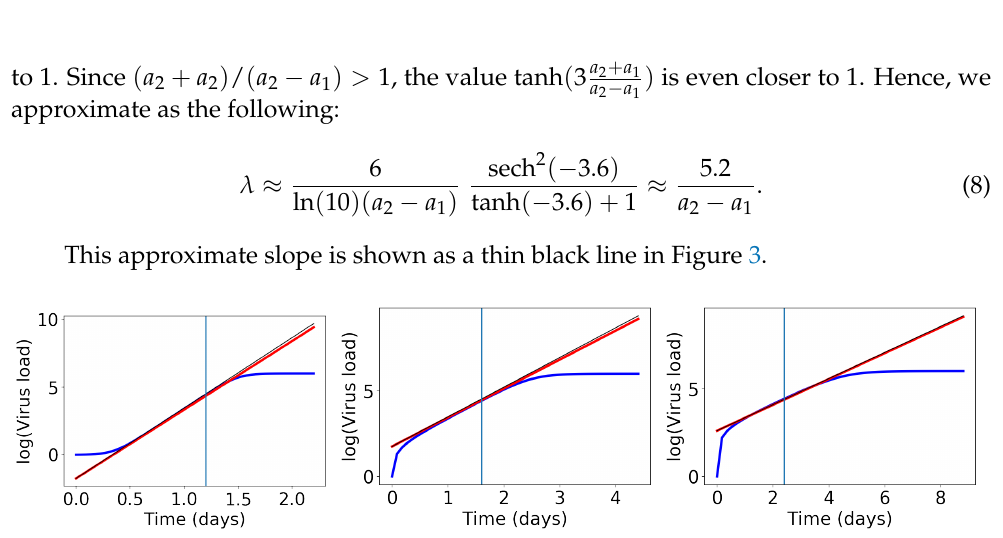
Figure 3. Comparison of exponential growth rates at the initial growth phase. The blue line shows log ( v 1 ( x )) , the red line a linear approximation with slope (7), and the thin black line a linear approximation with slope (8). Left: a 1 = 1, a 2 = 2, middle: a 1 = 1, a 2 = 4, right: a 1 = 1, a 2 =